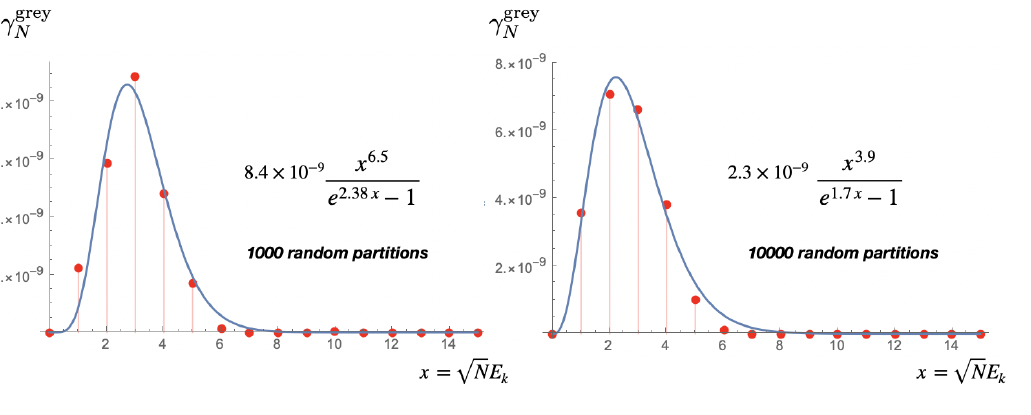
computed for two different π 1 ( g n )